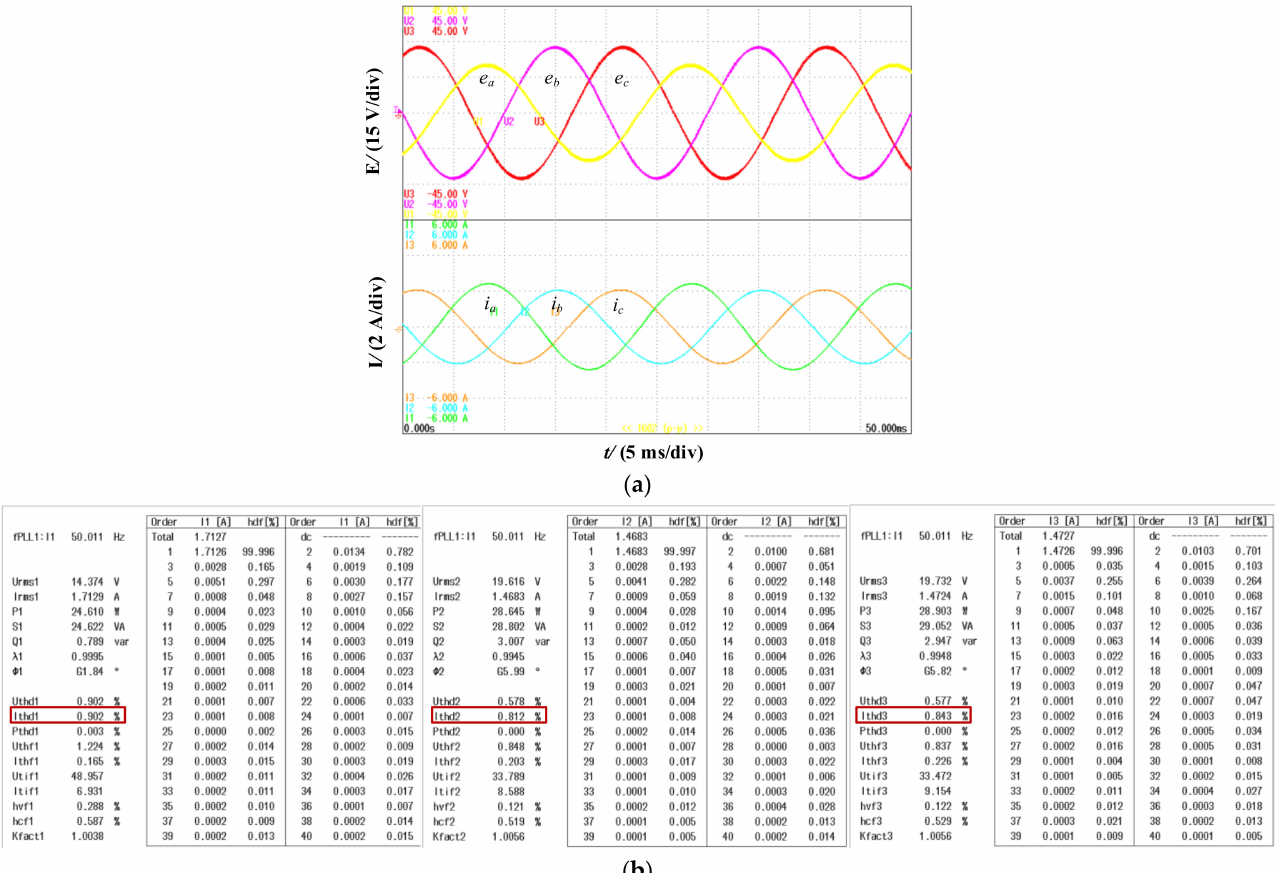
Figure 12. Experimental results of novel FCS-MPDPC under unbalanced grid voltages; ( a ) voltage and current waveforms; ( b ) spectrum analysis of current.